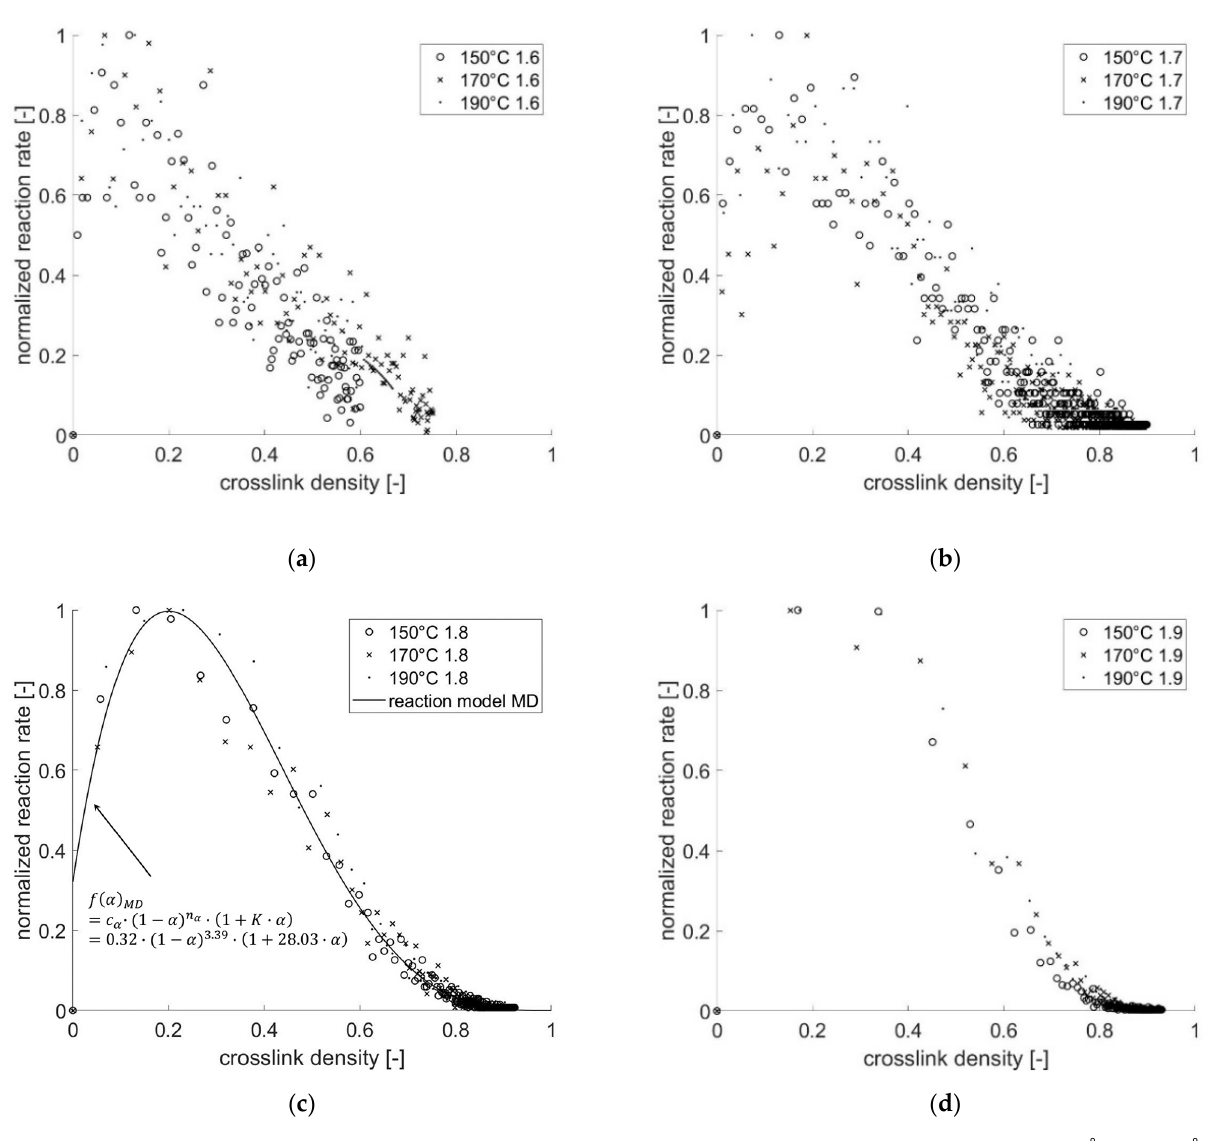
Figure 7. Reaction rate depending on crosslink density computed using varied cutoff distances of ( a ) 1.6 Å, ( b ) 1.7 Å, ( c ) 1.8 Å and ( d ) 1.9 Å. Table 5. Parameters in the reaction model estimated by regression with a confidence interval of 95 %.